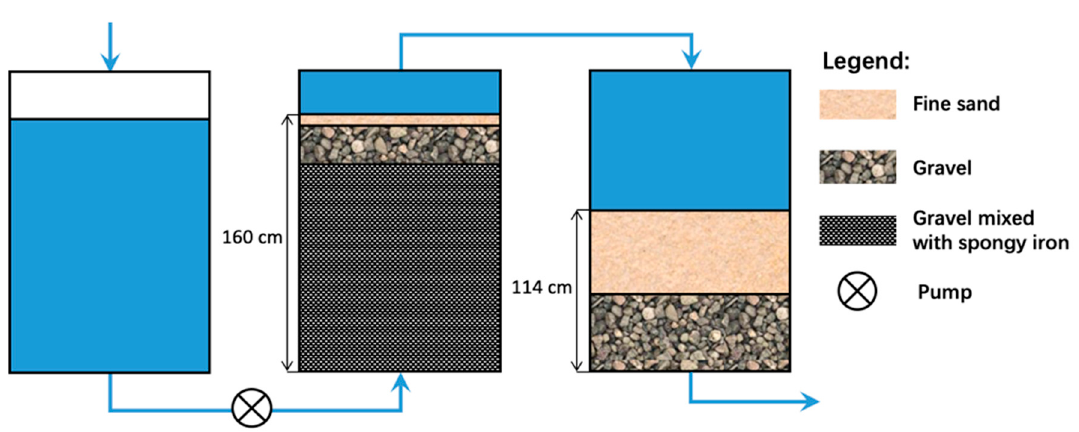
Figure 1. Schematic diagram of the Bischof’s spongy iron filter as described by Davis [42]. Arrows show the direction of water